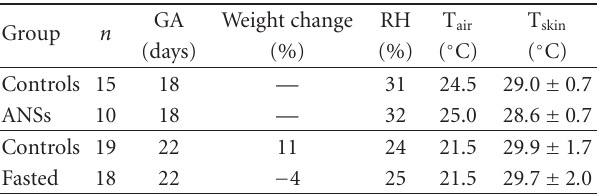
Table 1: Measurement